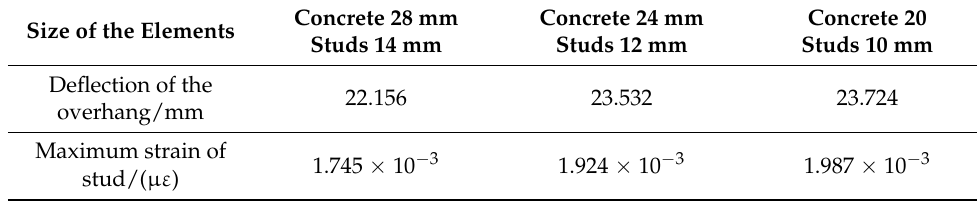
Table 4. Comparison of calculation results when the load is 100kN.